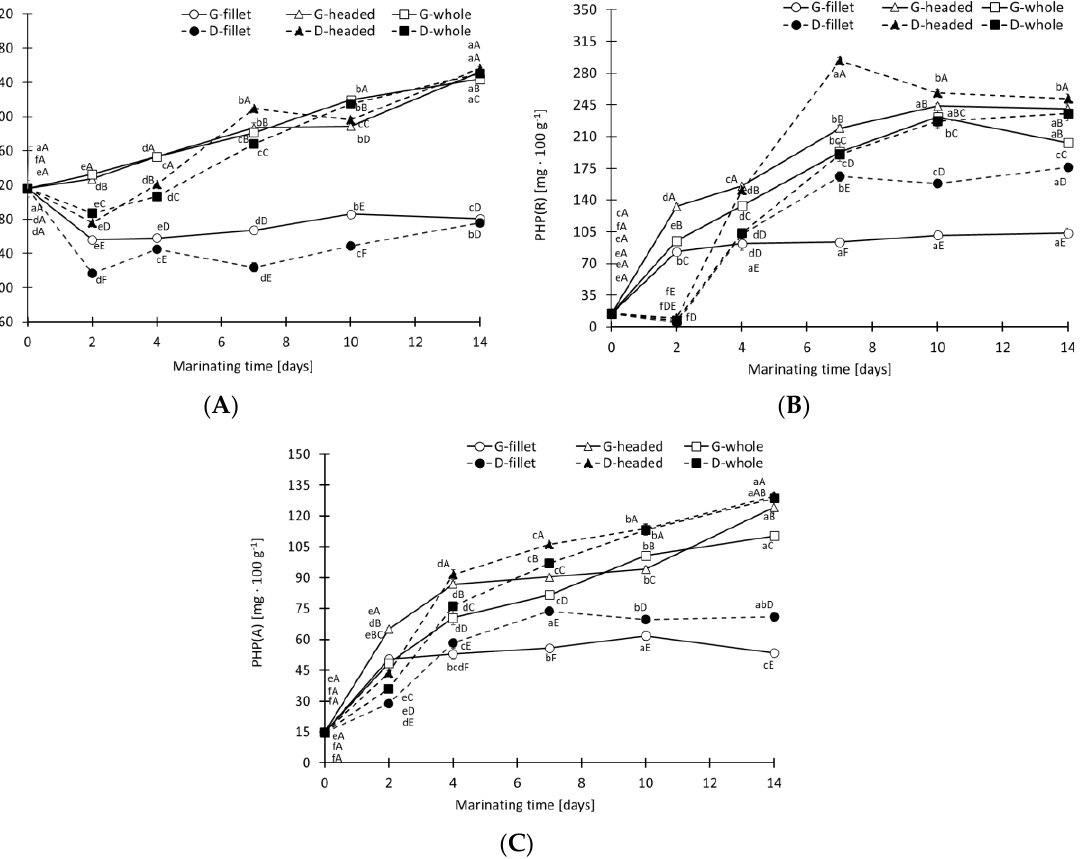
Figure 7. Effect of marinating method (G- — German, D- — Denmark) and degree of primary processing of Baltic herring (whole, headed, fillet) on concentration of ( A ) NPN, ( B ) PHP(R) and ( C ) PHP(A) during marinating. a,b,c Results marked with the same lower case letter do not statistically differ by the influence of marinating time; A,B,C Results marked with the same capital letter do not statistically differ by the influence of the marinating method.